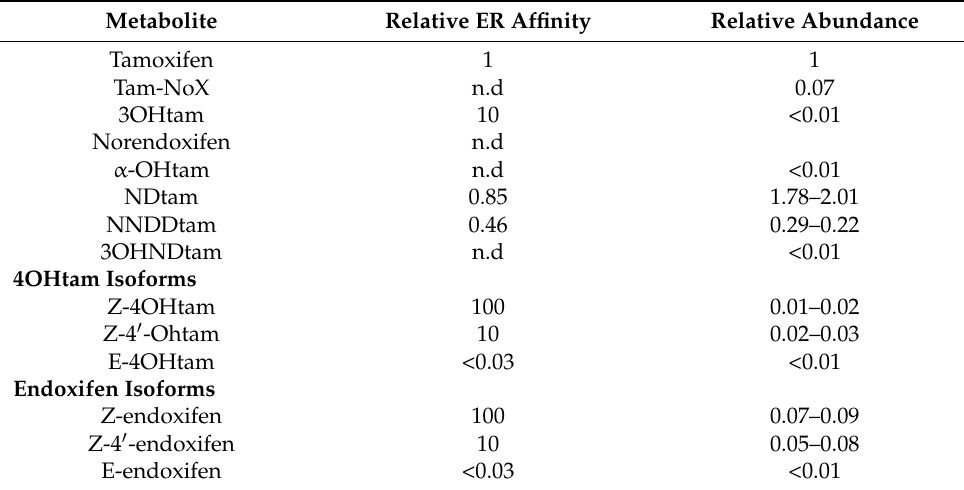
Table 1. Relative ER affinity and abundance of tamoxifen